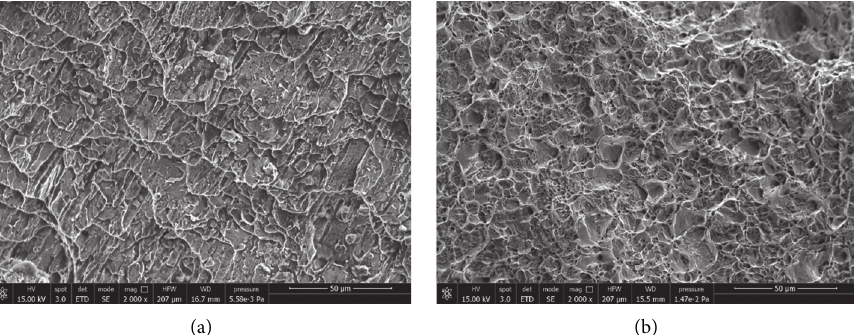
Figure 14: Fracture surface in correspondence of welding of (a) TempCore ® rebar with brittle structure and (b) micro-alloyed steel with ductile